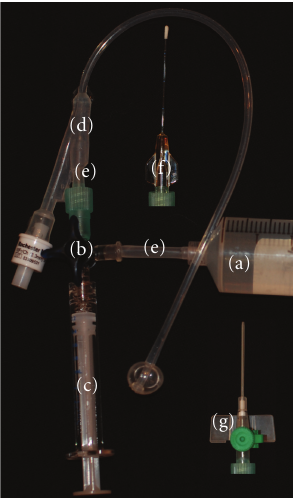
Figure 1: Fifty mL syringe containing LG (a), 3-way stopcock (b), syringe for injection (c), modified paediatric Foley catheter (d), polyethylene tubes (e), and inserts show LeGoo cannula (f) and intravenous cannula (g), both connected to 3-way stopcock.